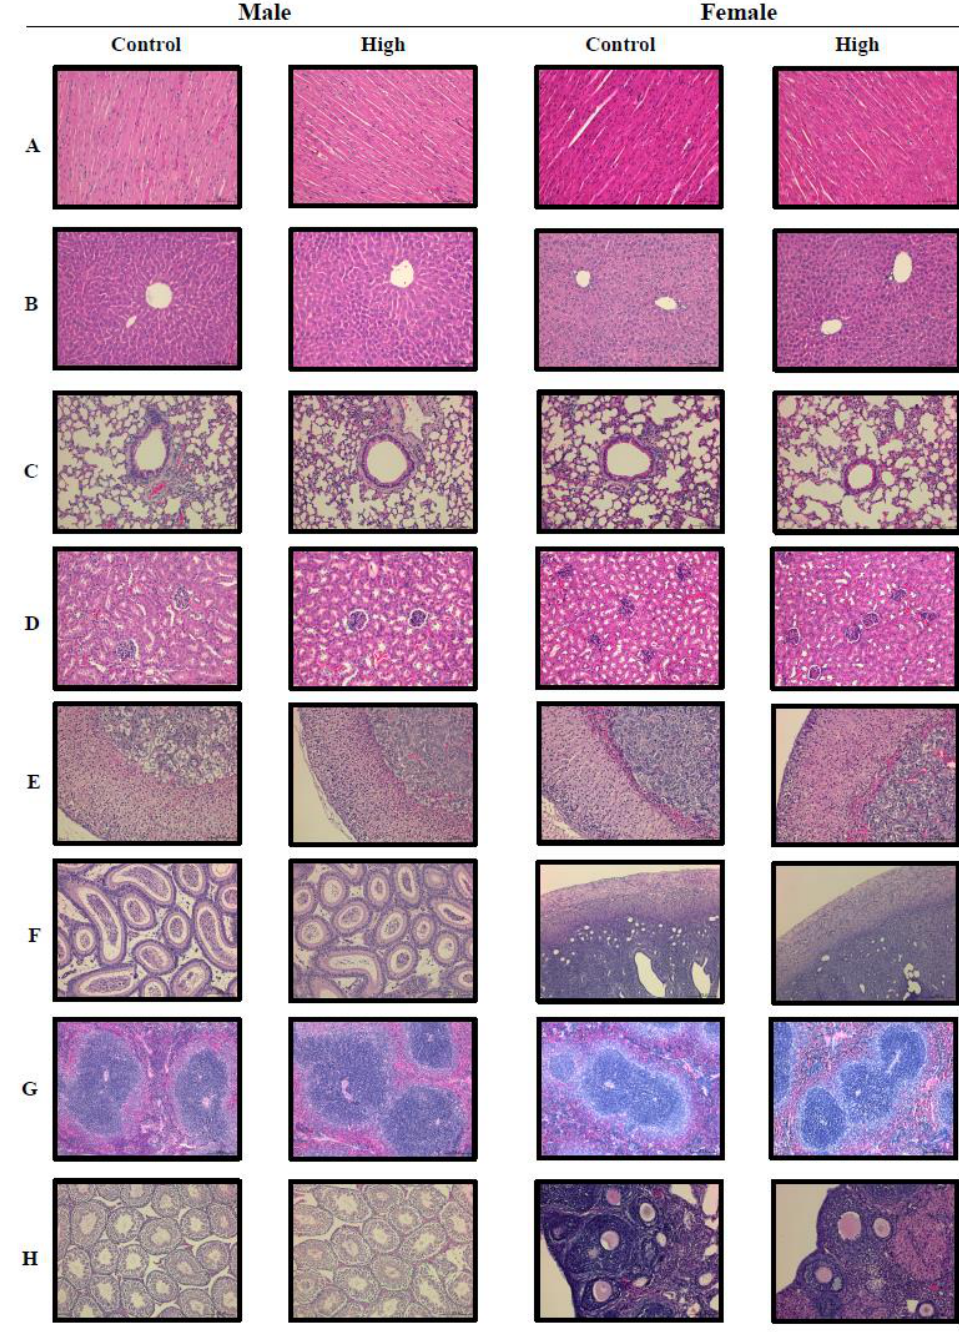
Figure 1. Analysis of histopathology in the ICR mice from the L. paracasei PS23 28-day toxicity test. Representative images of the histopathological demonstration for the male control ICR mice and the high dose (4000 mg/kg) groups include the heart ( A ), liver ( B ), lung ( C ), kidneys ( D ), adrenal glands ( E ), epididymis ( F ), spleen ( G ), and testis ( H ) (H&E stain, 200×) (left panel). Representative pictures from the female control ICR mice and the high-dose (4000 mg/kg) groups include the heart ( A ), liver ( B ), lung ( C ), kidneys ( D ), adrenal glands ( E ), uterus ( F ), spleen ( G ), and ovaries ( H ) (H&E stain, 200 × ) (right